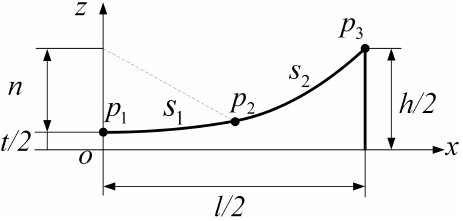
Figure 2. The 2-D schematic of the ellipse-parabola shaped flexure